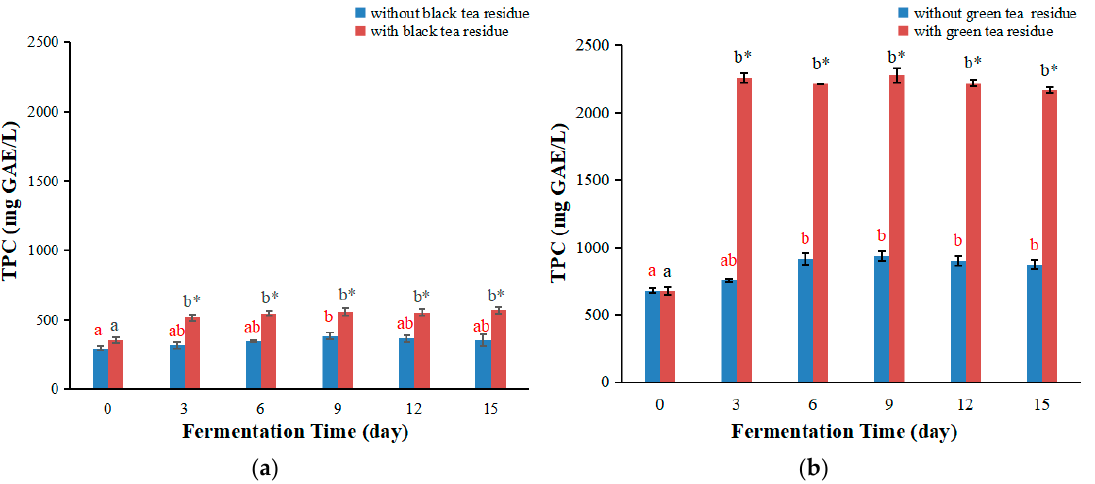
Figure 4. Changes of TPC values of kombucha produced by fermentation with or without tea residue at different fermentation stages. ( a ) TPC values of kombucha from black tea; ( b ) TPC values of kombucha from green tea. Different letters illustrate significant differences ( p < 0.05) for the same kombucha beverage at different fermentation times, and the same letter represents no significant difference ( p > 0.05). Different colors of letters represent different kombucha fermentation with tea residue or without tea residue. * Indicates significant difference ( p < 0.05) between kombucha fer- mentation with tea residue and kombucha fermentation without tea residue at the same fermenta- tion time.